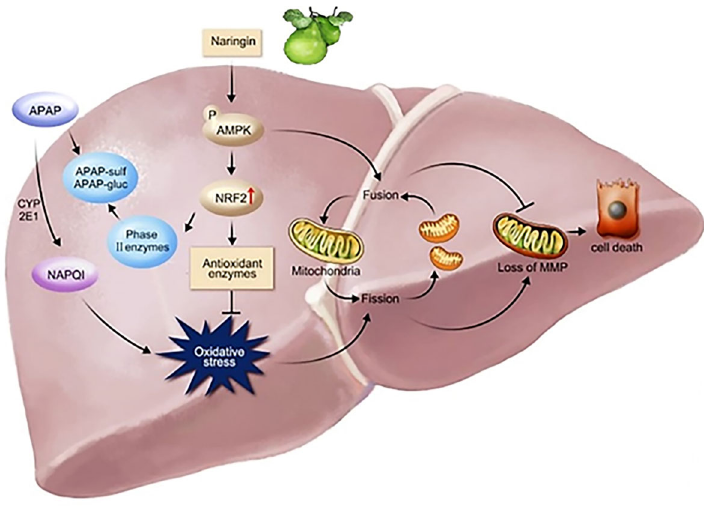
Figure 7. Mechanisms by which naringin (Nar) can prevent acetaminophen (APAP)-induced hepatocyte damage.